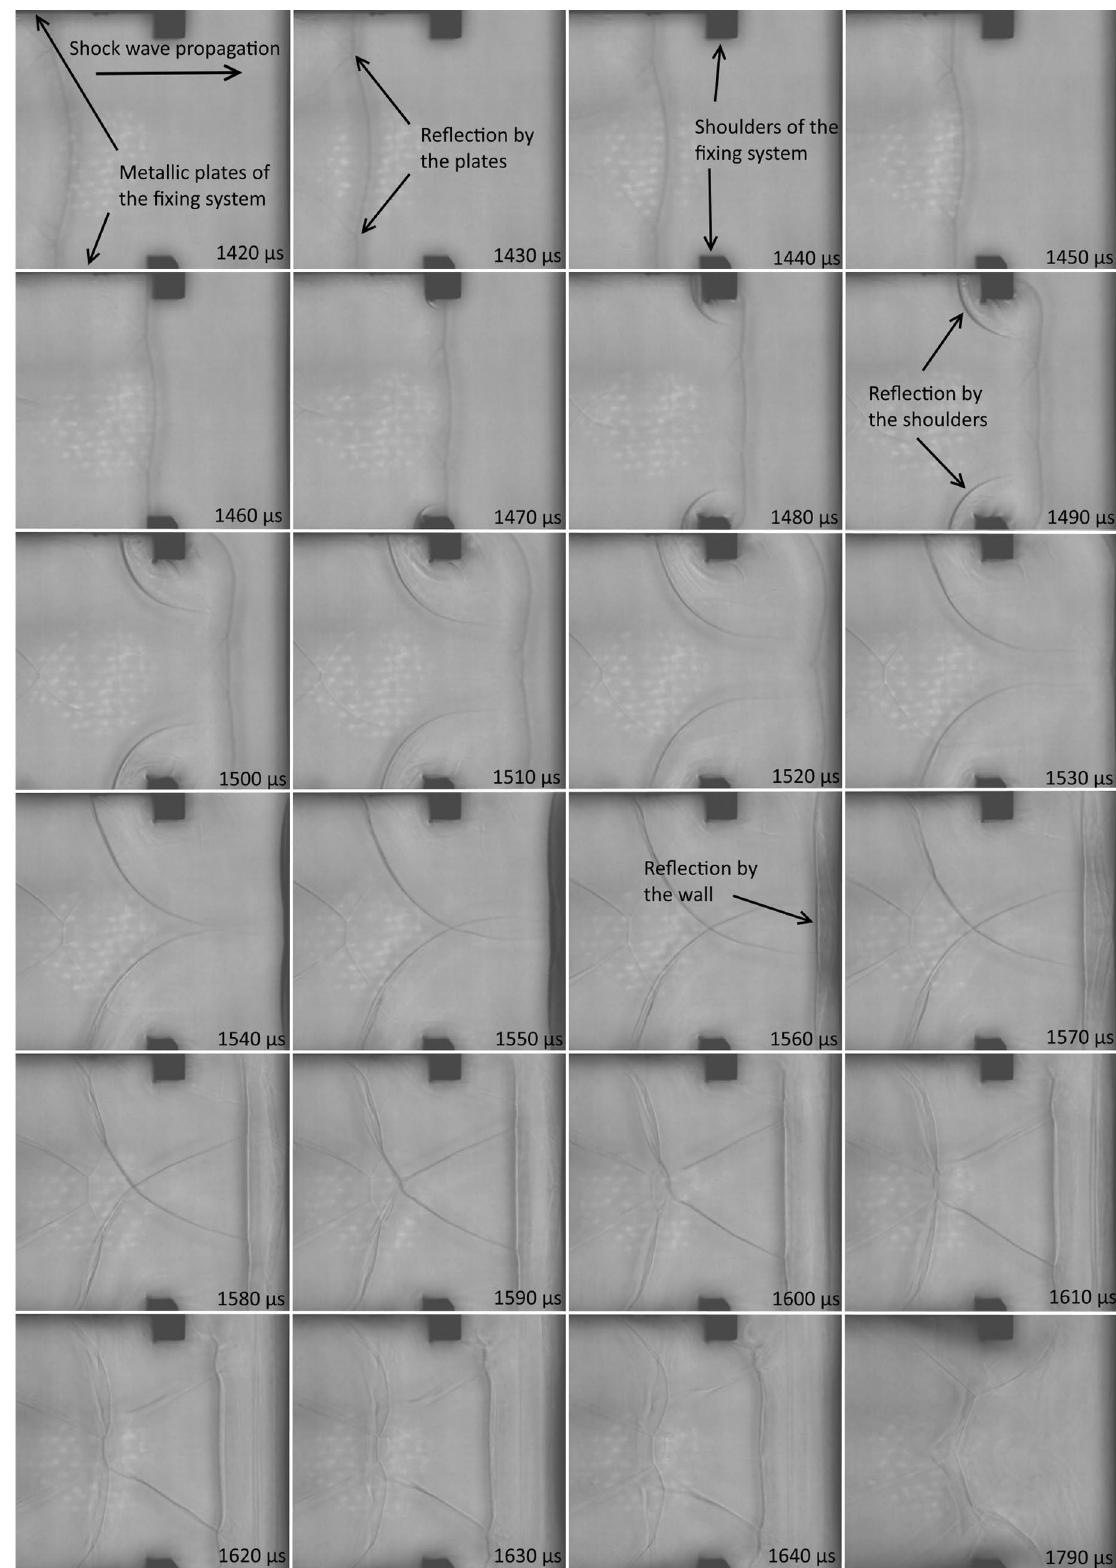
Fig. 6 Photographs resulting from fast video recording, showing the shock wave propagation at the outlet of the EDST (10 µs between each